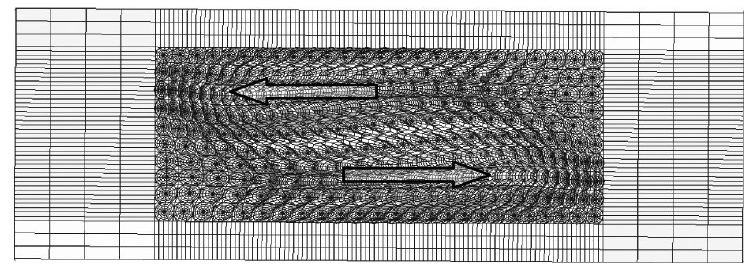
Fig. 42. EIDL 2nd mode – 907 Hz – in plane opposite horizontal translation.